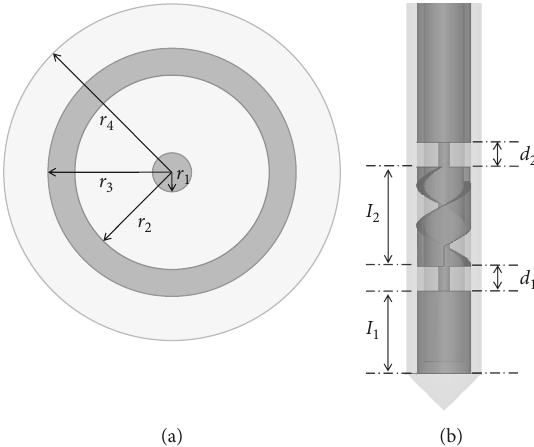
Figure 1: (a) Schematic view of internal construction of the coaxial antenna and (b) helical slot part.